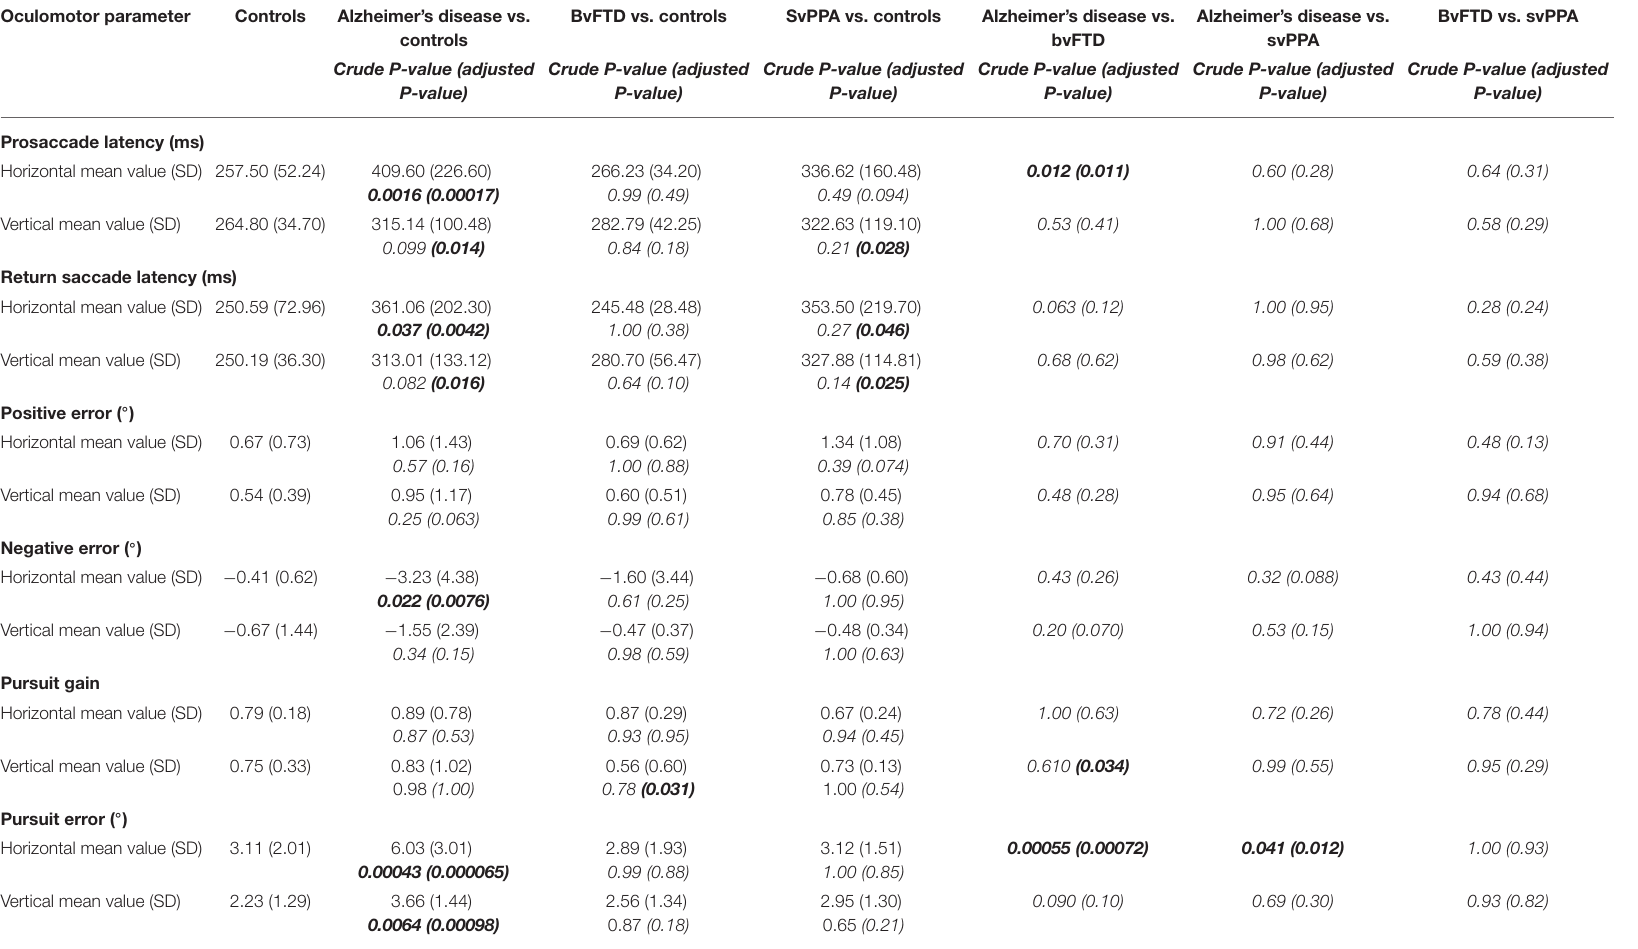
TABLE 2 | Visually-guided responses: Prosaccade test and sinusoidal smooth pursuit